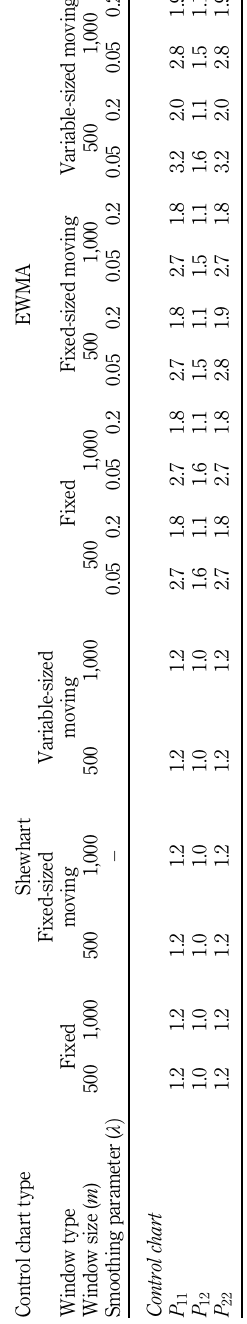
Table 8. Out-of-control AARL values for the Shewhart and EWMA control charts when m 5 500 and